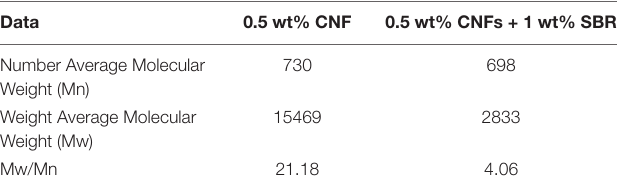
TABLE 5 | GPC data of samples with and without